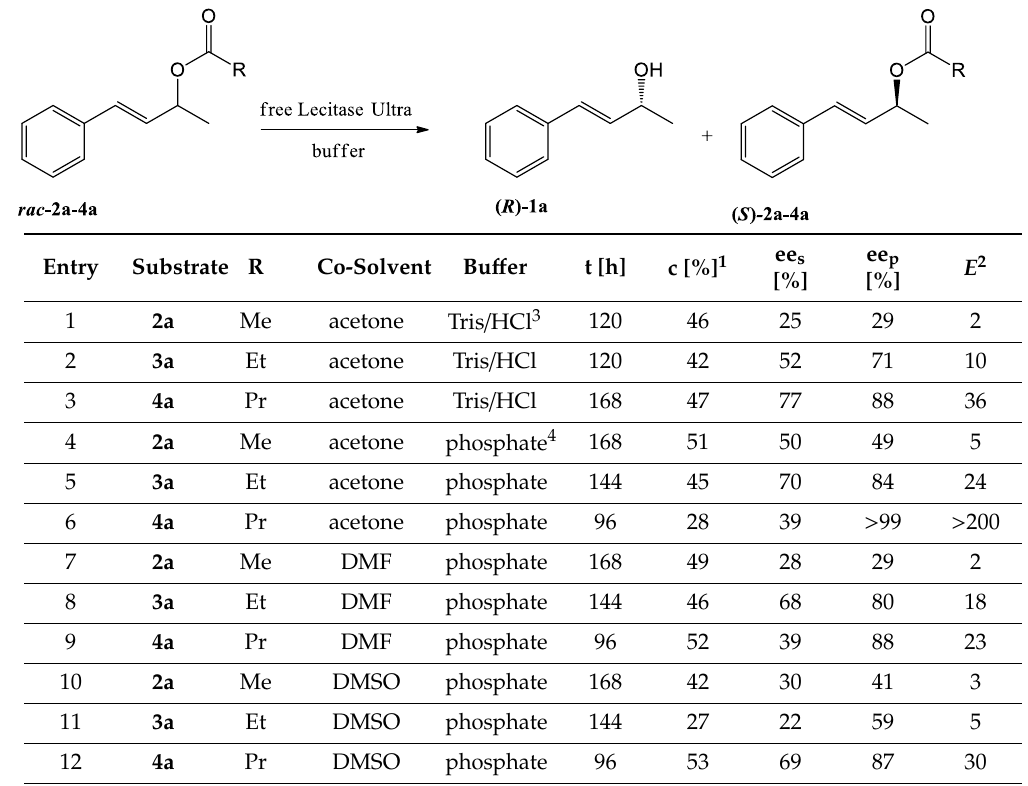
Table 1. Free Lecitase ™ Ultra-catalyzed hydrolysis of racemic esters 2a–4a.